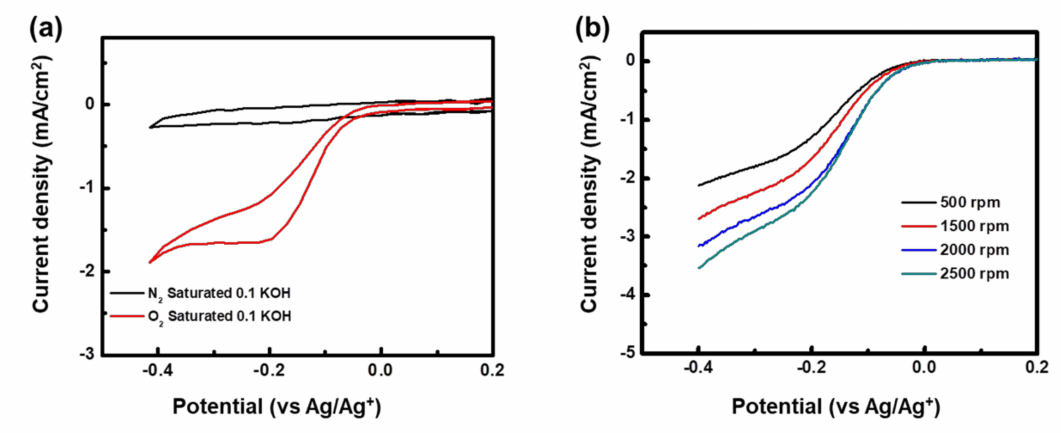
Figure 4. ( a ) Cyclic voltammetry curves for CPP-P2 under N 2 -saturated and O 2 -saturated 0.1 (M) KOH electrolyte. ( b ) Linear sweep voltammetric curves observed under di ff erent rotation speeds for the glassy carbon electrode for CPP-P2.